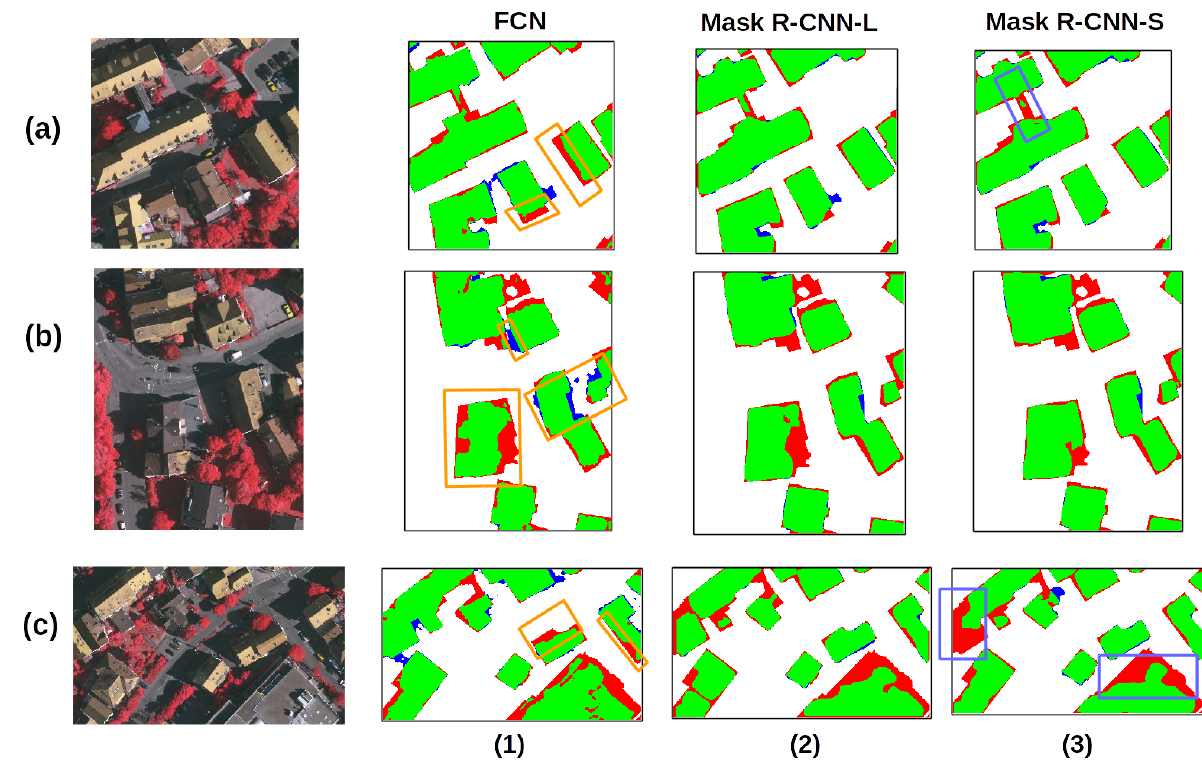
Figure 4. The pixel-based evaluation of building segmentation results on three areas. Green: correctly detected building pixels. Red: miss-detected building pixels. Blue: wrongly detected building pixels. Blue boxes in the result of Mask R-CNN-S show the miss-detected pixels due to small anchor scales selected. Yellow boxes in the result of FCN show more wrongly segmented pixels in building edges than Mask R-CNN.